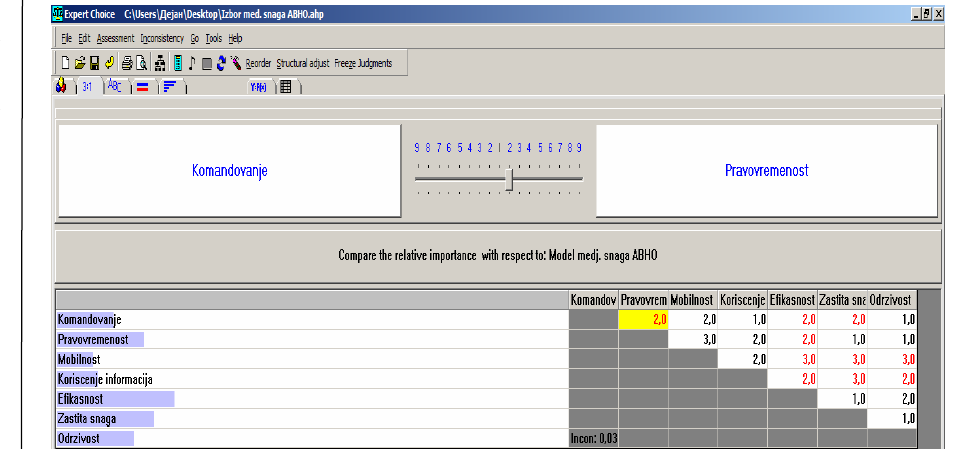
Table 5 – Comparison of the attributes at the second level Таблица 5 – Сравнение атрибутов на втором